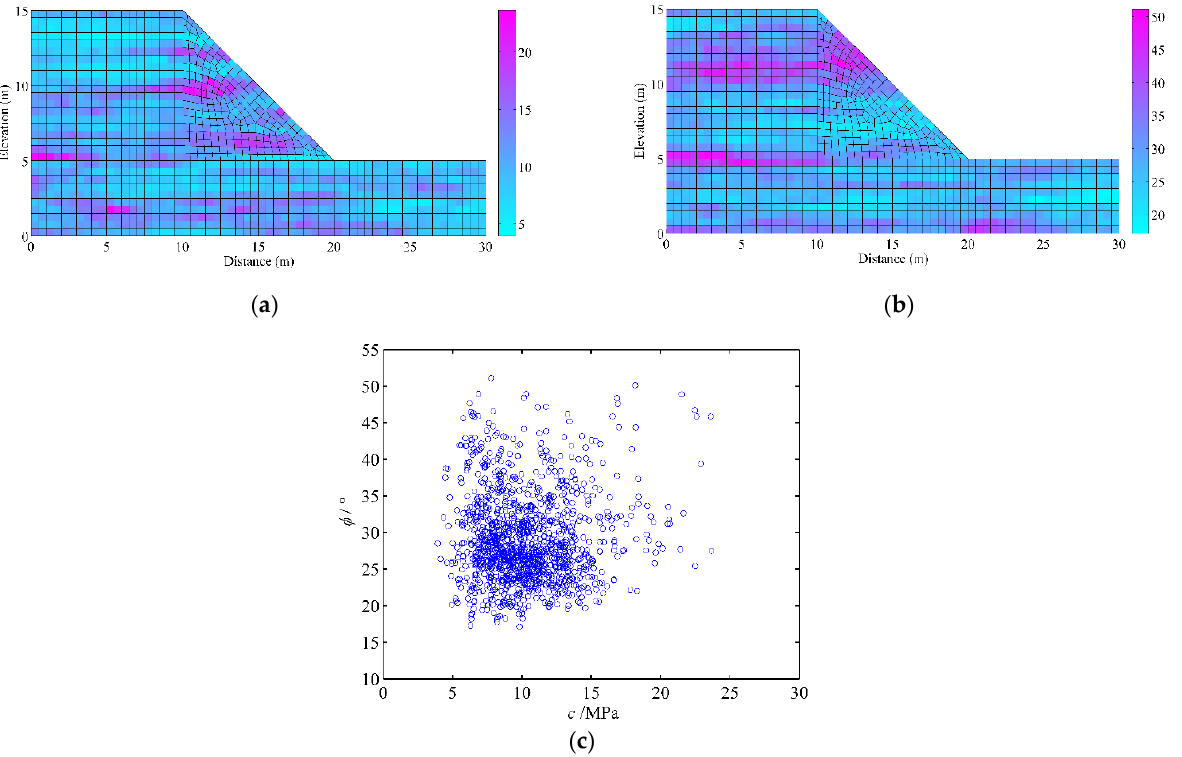
Figure 9. A typical realization of independent and non-correlation random field. ( a ) Random field of c . ( b ) Random field of ϕ. ( c ) Scatter plot of independent and non-correlation random field.